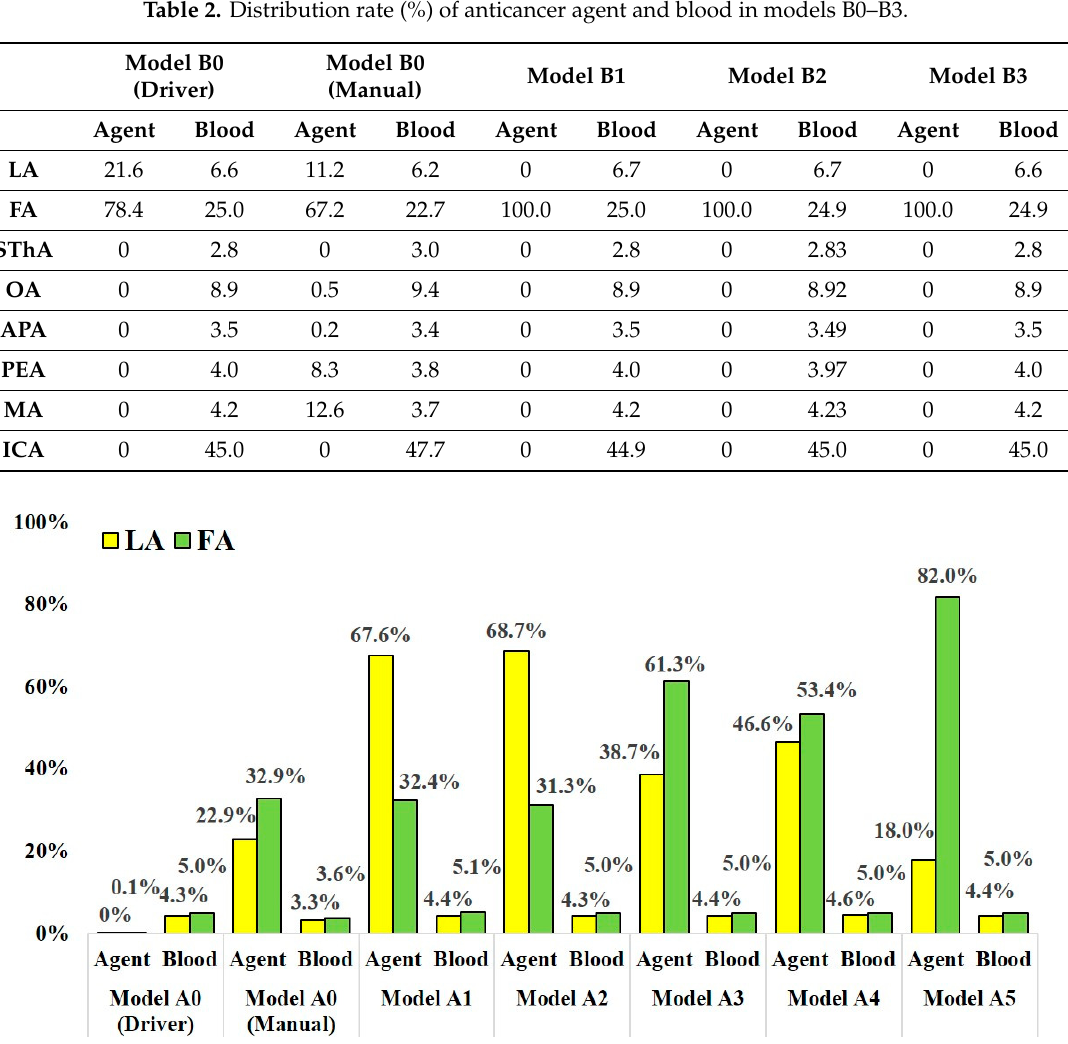
Table 2. Distribution rate (%) of anticancer agent and blood in models B0–B3.